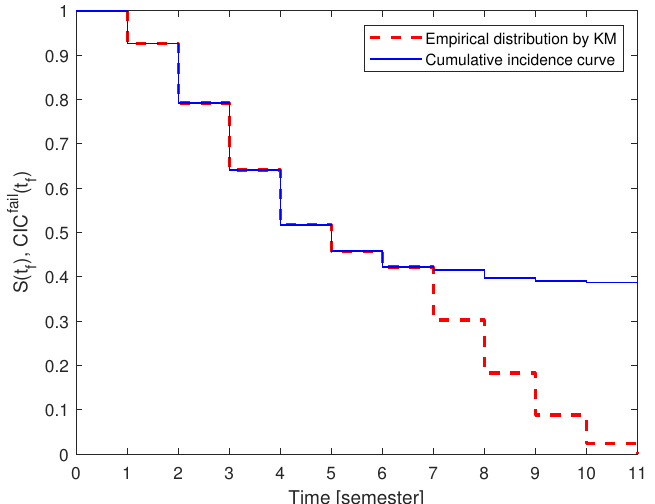
Figure 3. The empirical distribution by the Kaplan–Meier method (KM) (red) and the Cumulative Incidence Curve of non-graduate students (blue). Since the competitive risk of graduation appears only from the 7th semester (the length of the sample curriculum), it is expected that the two functions will be different from this semester. The difference determines the graduated students.